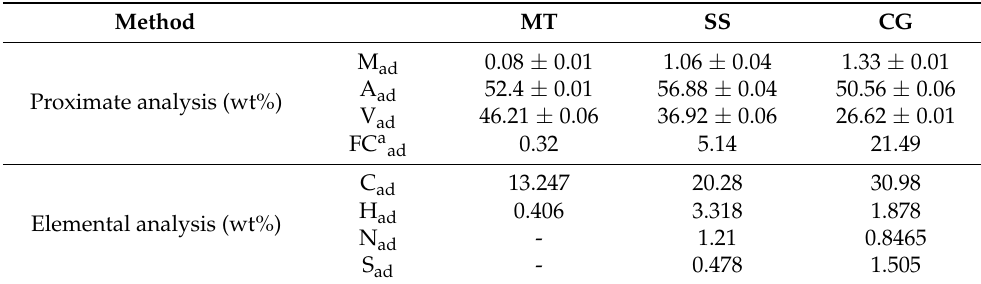
Table 2. Proximate analysis and elemental analysis of MTs, SS, and CG.